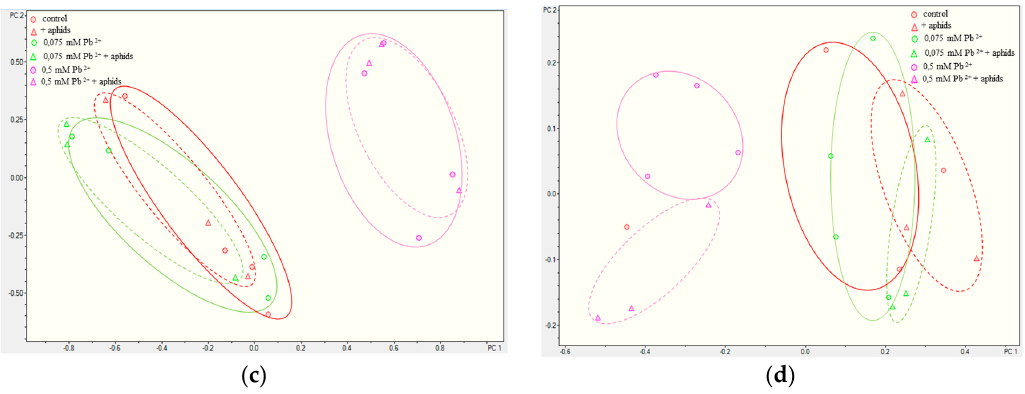
Figure 5. Quantitative analysis of metabolites in roots ( a , c ) and leaves ( b , d ) of pea seedlings. The Principal Components Analysis (PCA) of the positive ion ( a , b ) and negative ion ( c , d ) MS shows distinct and close clustered groups of these ions for experimental variants, i.e., control, +aphids, 0.075 mM Pb 2+ , 0.075 mM Pb 2+ +aphids, 0.5 mM Pb 2+ and 0.5 mM Pb 2+ +aphids